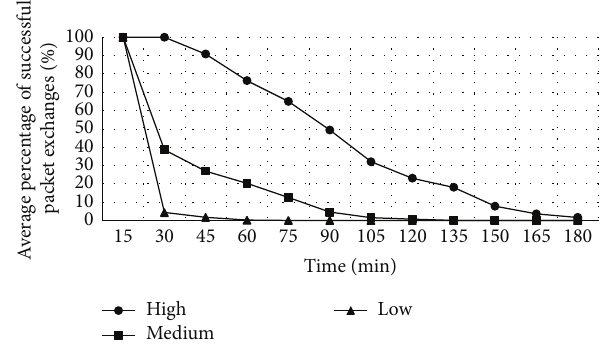
Figure 7: Battery consumption of